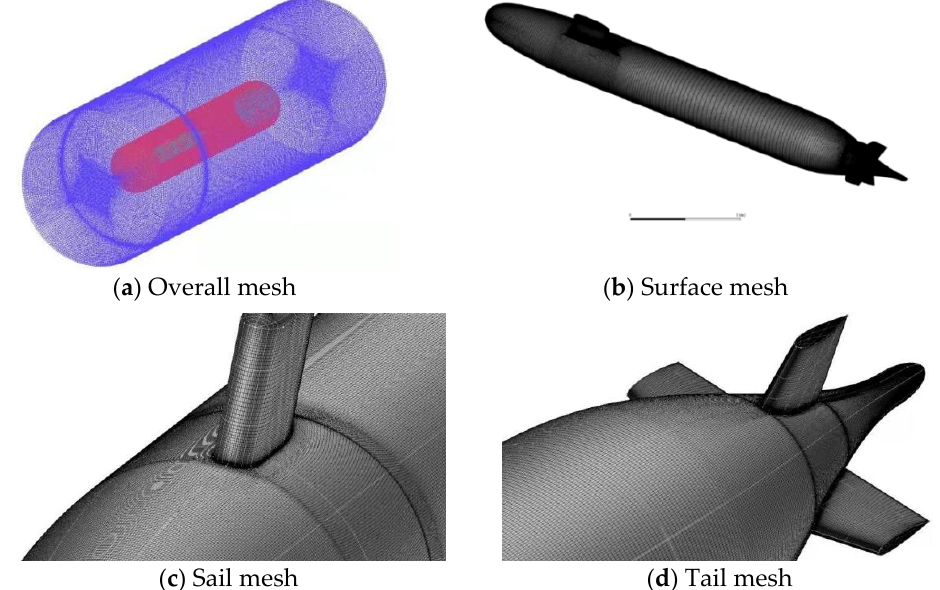
Figure 3. Mesh of SUBOFF.